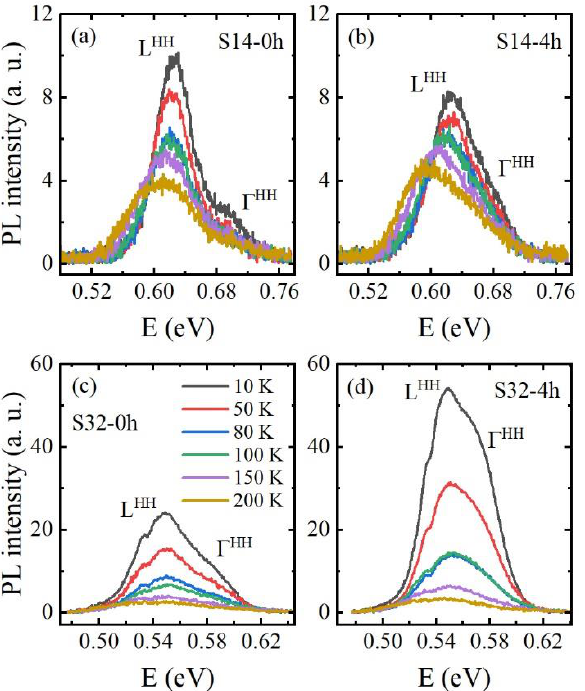
Figure 7. The temperature dependent PL from the GeSn layer of samples S14 and S32. ( a ) S14-0h; ( b ) S14-4 h; ( c ) S32-0 h; ( d ) S32-4 h. The increase of peak intensity ratio Γ HH /L HH with temperature is shown in Figure 8.